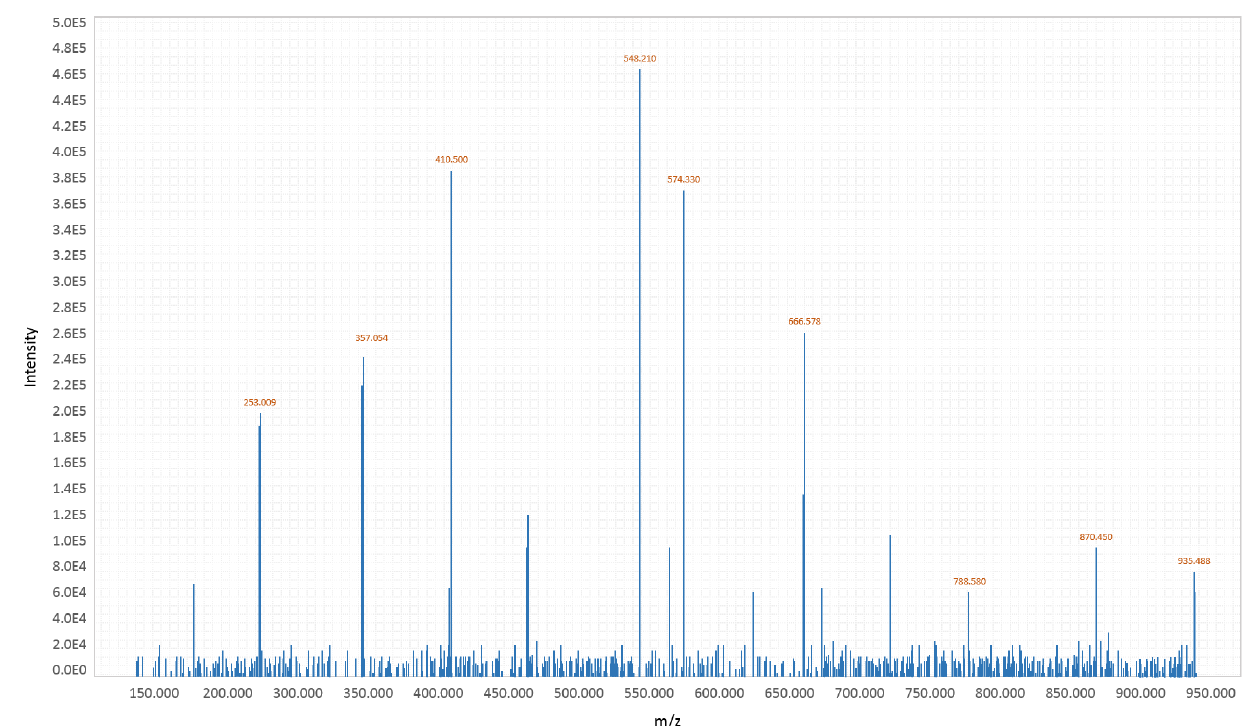
Figure 2 - Mass spectrometry spectrum – scheme of metabolite output